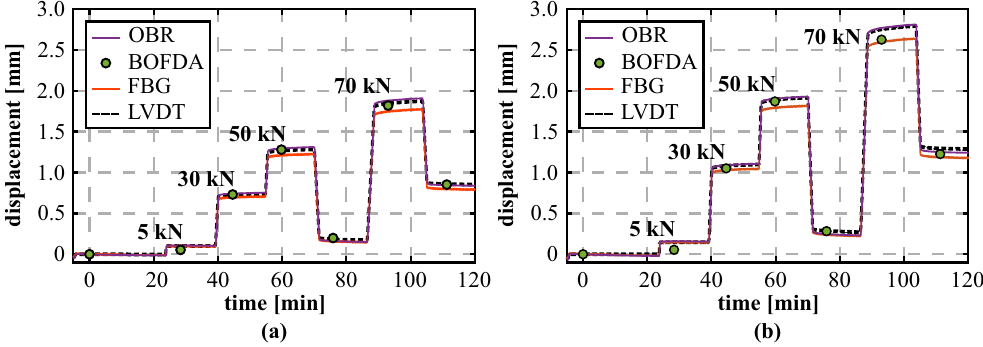
Figure 14. Comparison between DFOS and LVDT displacements over time: ( a ) LVDT left ( − 1.50 m). ( b ) LVDT center (+0.00